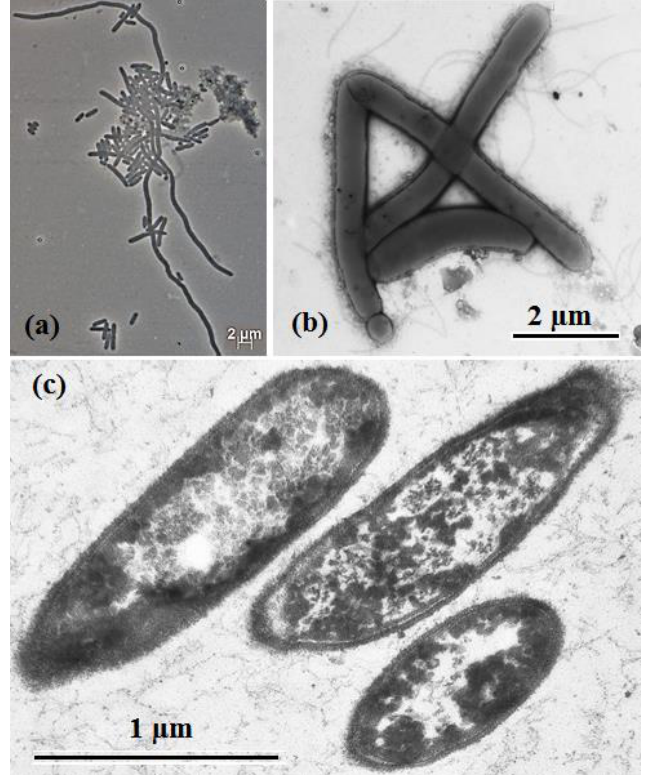
Figure 1. Phase contrast micrographs of cells: ( a ) transmission electron micrographs of negatively stained flagellated cells, ( b ) sections ( c ) of strain 1933P T grown for 120 h in mineral medium (MM) with peptone and yeast extract at 35 °C.